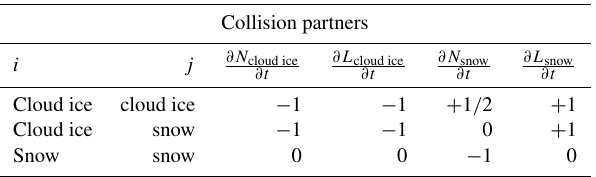
Table A1. Prefactor (cid:56) of the aggregation rates (Eq. A2) for different aggregation processes and the predicted moments of the cloud ice and snow